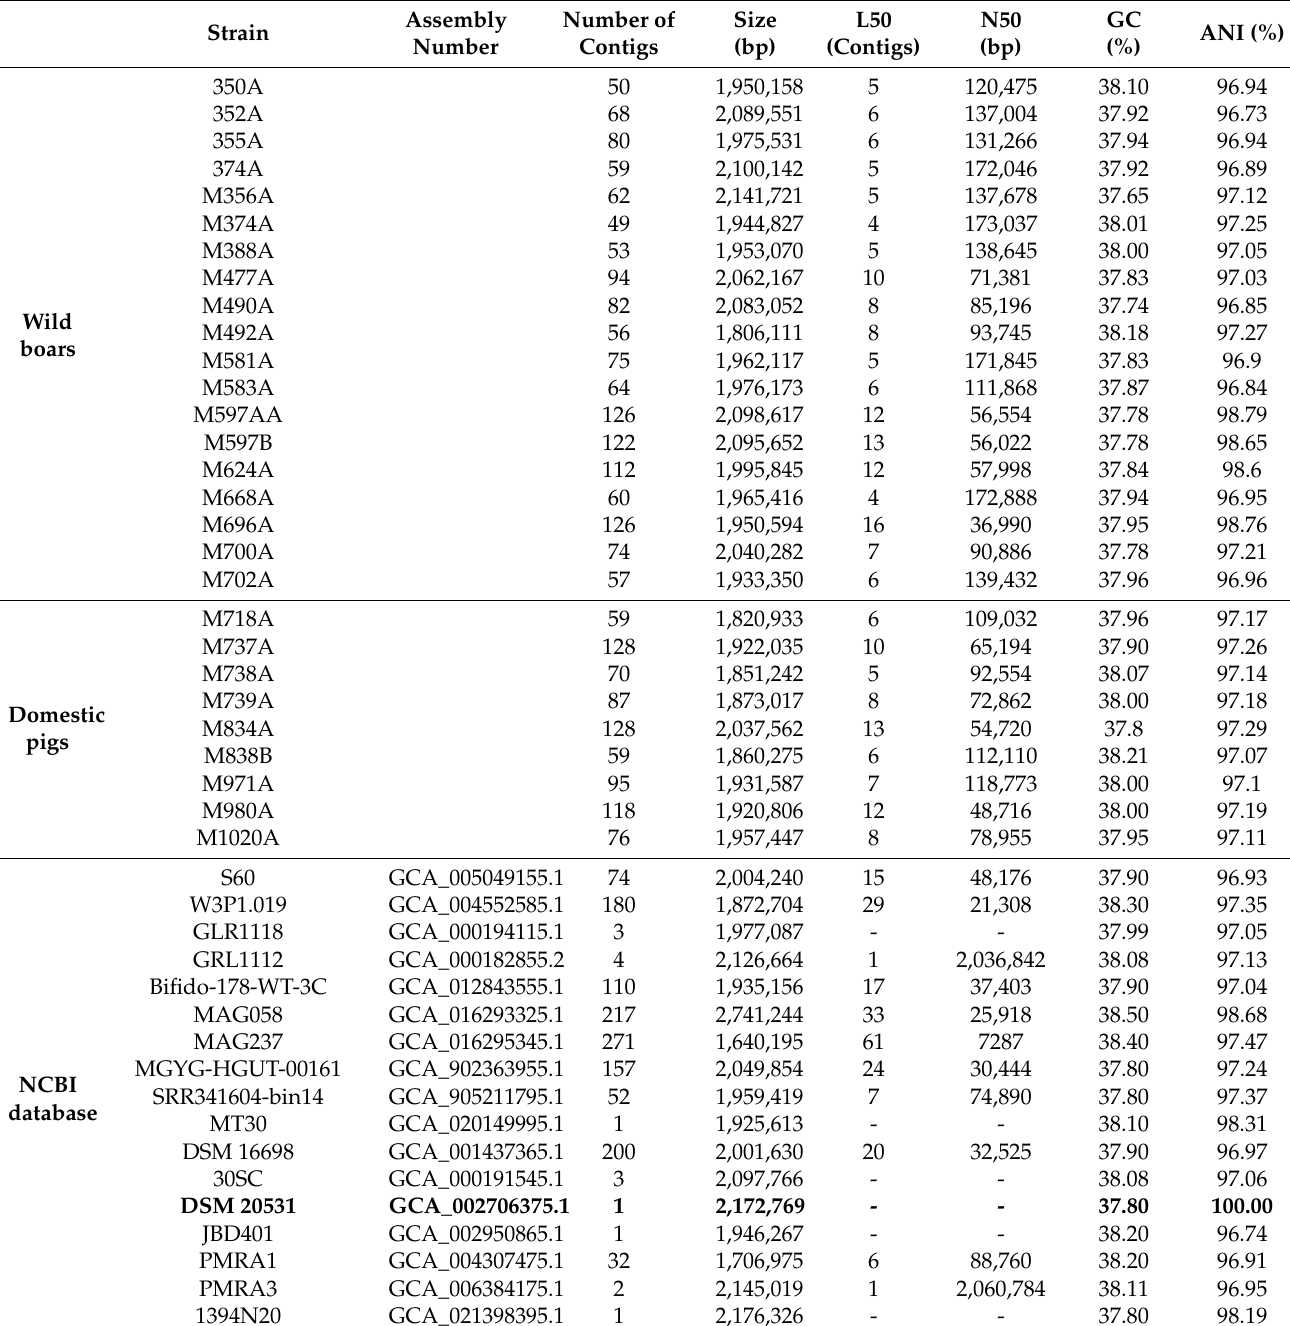
Table 2. Genome assembly and ANI values in L. amylovorus